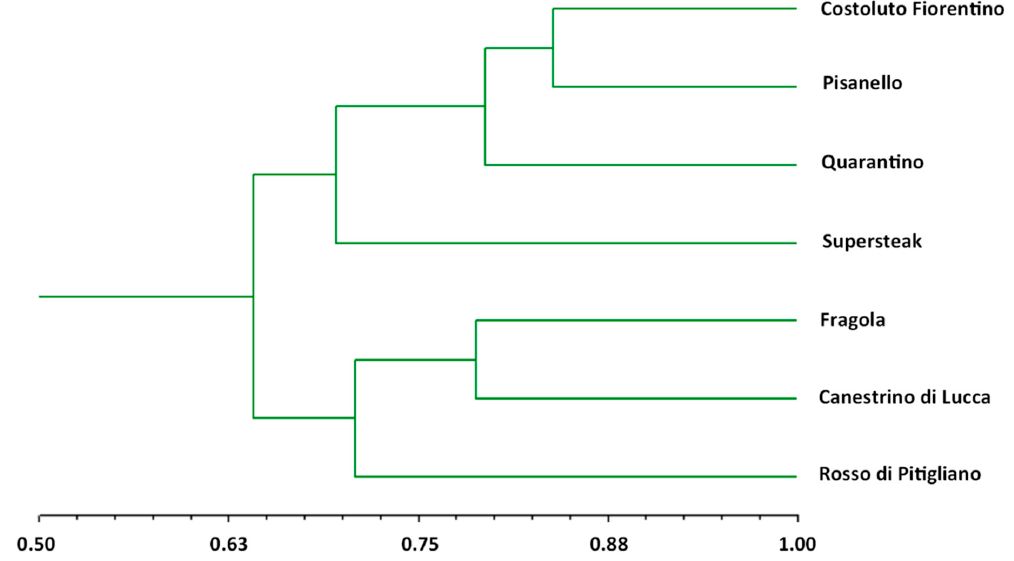
Figure 1. Hierarchical clustering (UPGMA algorithm) of six local varieties and one commercial cultivar (‘Supersteak’).